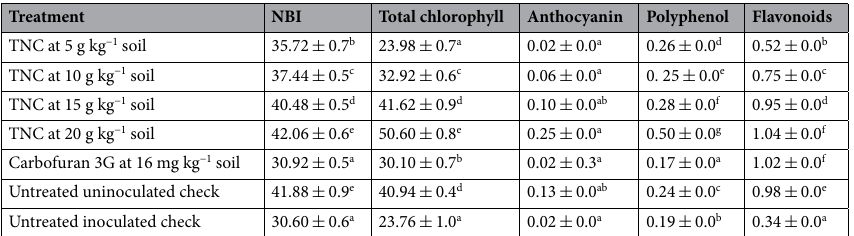
Table 3. Efficacy of T. asperellum FbMi6 enriched neem cake on biochemical and physiological parameter of okra infected with M. incognita . Data are mean of five replicates. Values with the different letter are significant according to DMRT (p < 0.05). Data are presented as means ± SD. NBI nitrogen balance index, TNC T. asperellum FbMi6 enriched neem cake.